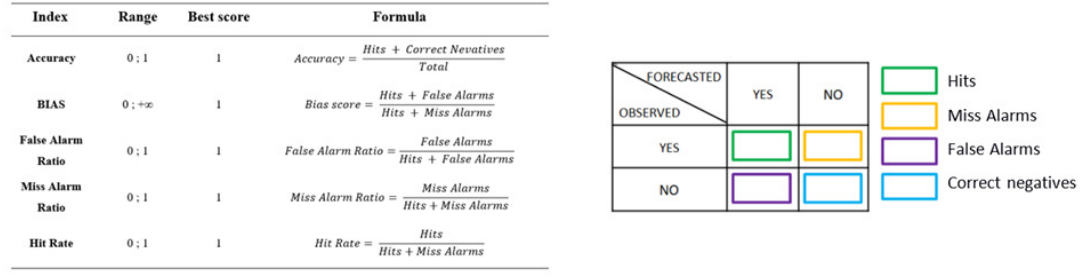
Figure 2. Contingency tables and statistical indices used in the evaluation for the ice alert code